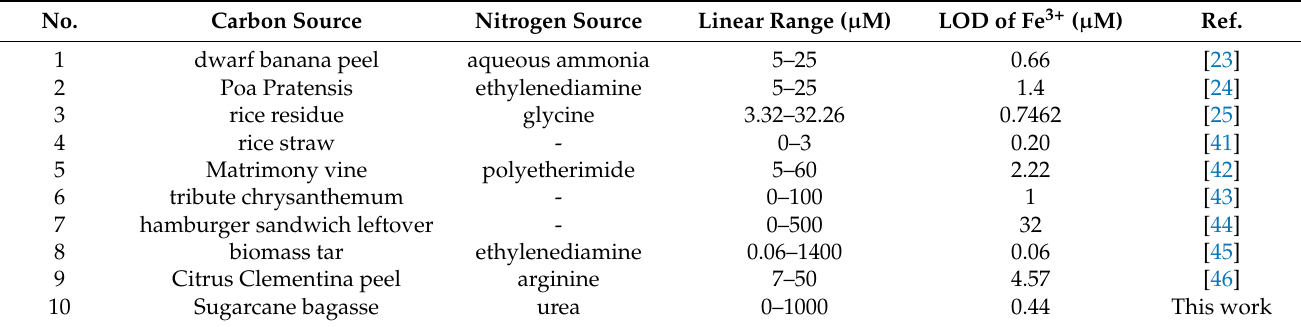
Table 1. Comparison of some reported hydrothermal-prepared biomass-based nitrogen-doped CQDs for detecting Fe 3+